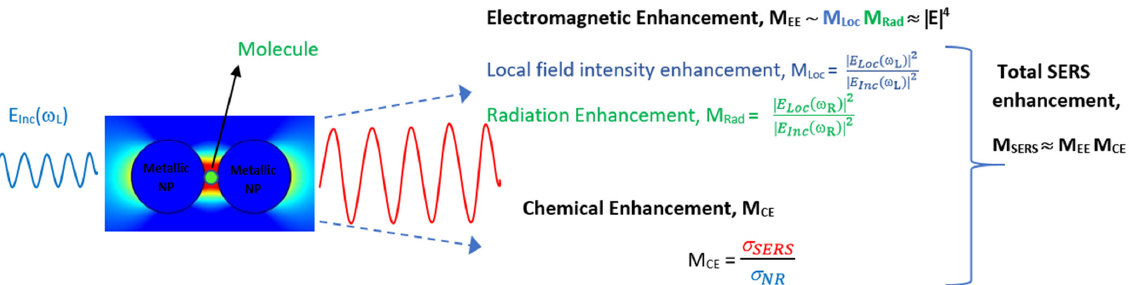
Figure 1. Schematic of total enhancement in SERS via electromagnetic and chemical enhancement mechanisms.